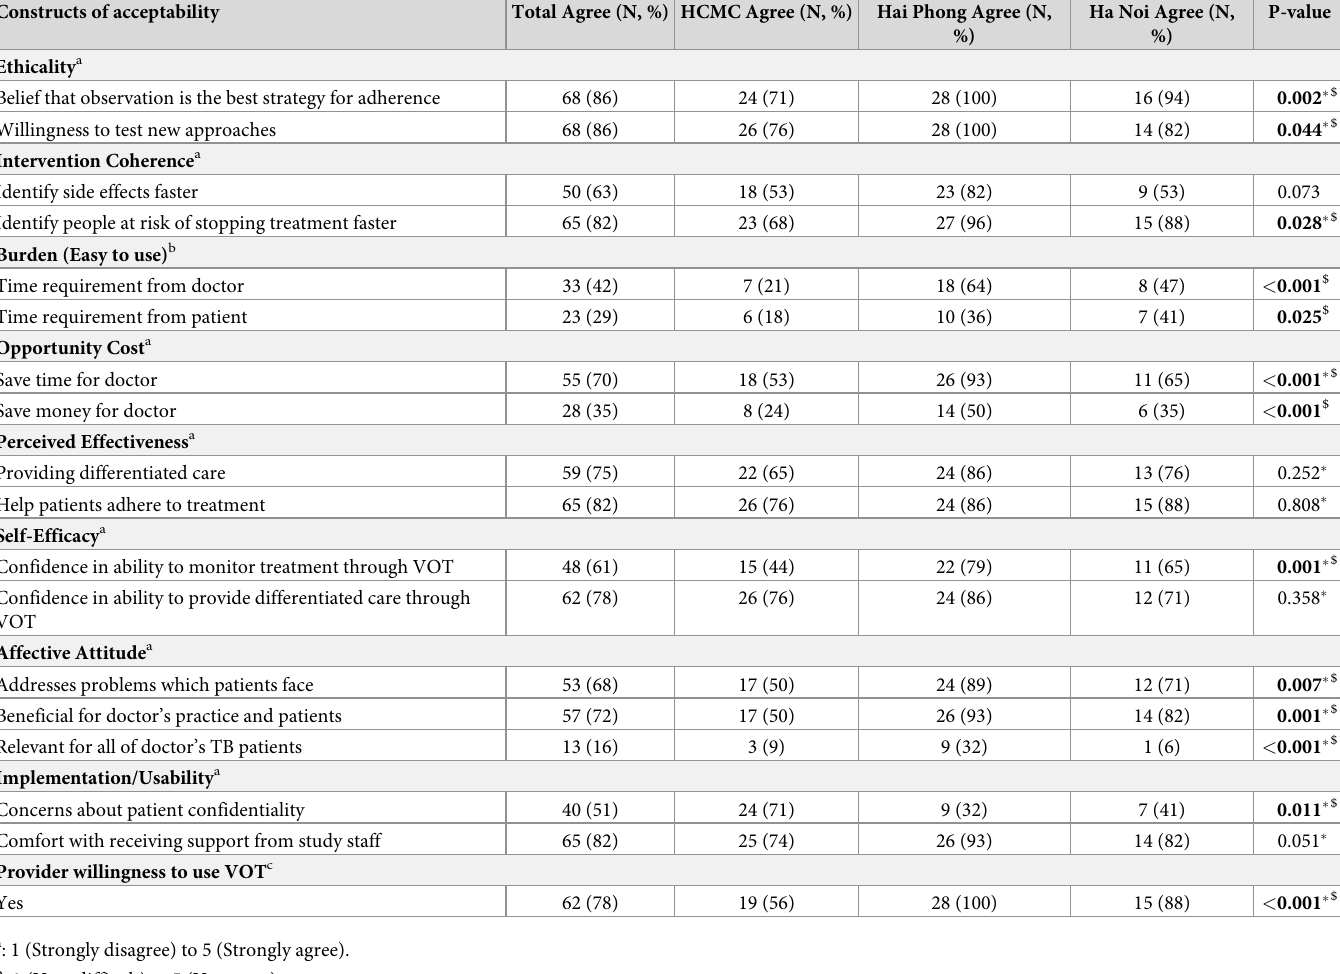
Table 2. Overall attitudes of private providers towards